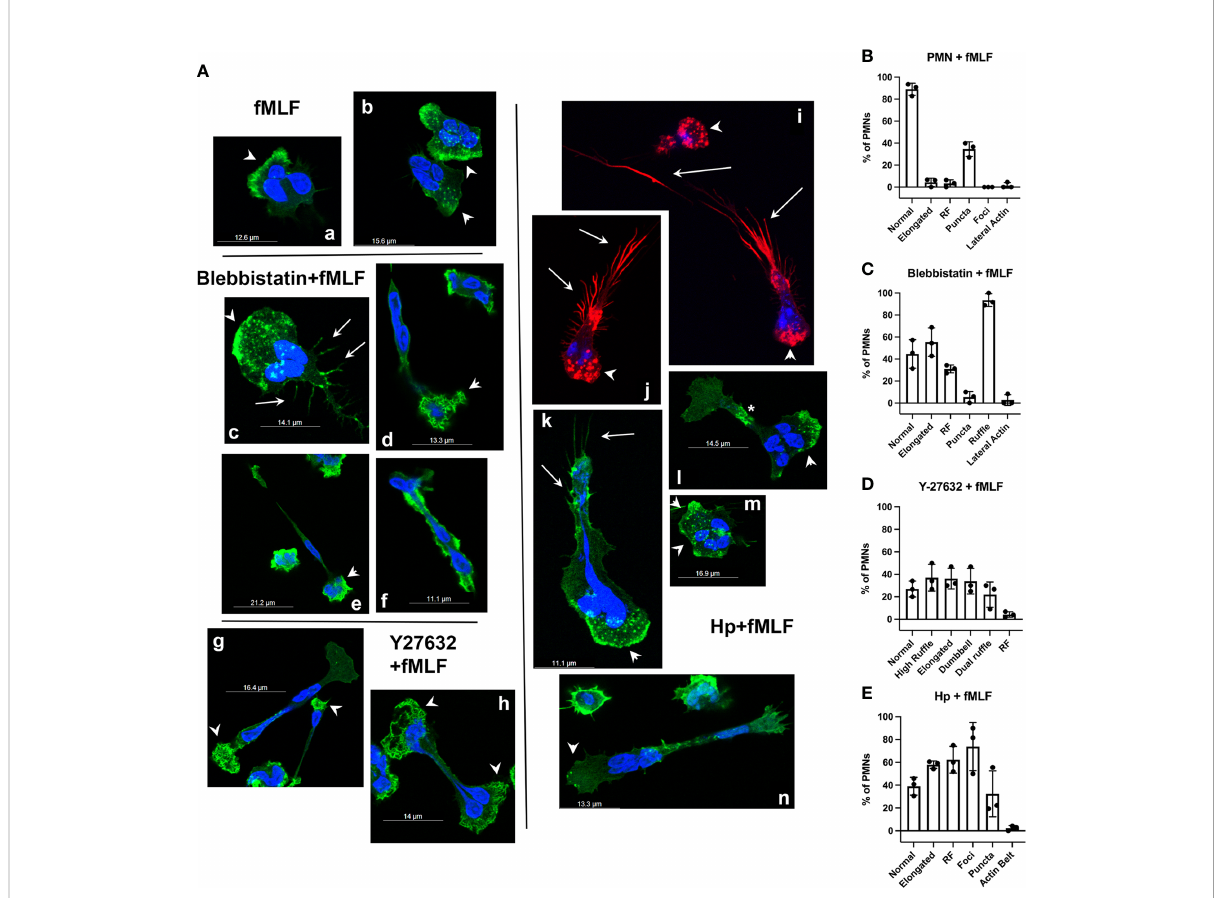
FIGURE 7 Effects of inhibitors and infection on F-actin structures in neutrophils migrating toward fMLF. (A) Representative confocal 3D Z-stack images of PMNs migrating toward fMLF in MatTek ™ dishes are shown. Cells were stained with DAPI to detect DNA (blue) or rhodamine-phalloidin to detect F-actin (red or green pseudocolor). fMLF controls ( images a, b ). Blebbistatin-treated cells ( images c – f ). Y-27632-treated cells ( images g, h ). H . pylori -infected cells ( images i – n ). Arrowheads , actin-rich ruf fl es and foci at the leading edge or cell poles. Arrows , actin-rich spikes/ retraction fi bers at the uropod. Asterisk , F-actin belt. Hp, H . pylori . (B – E) Quantitation of F-actin features in control (B) , Blebbistatin-treated (C)